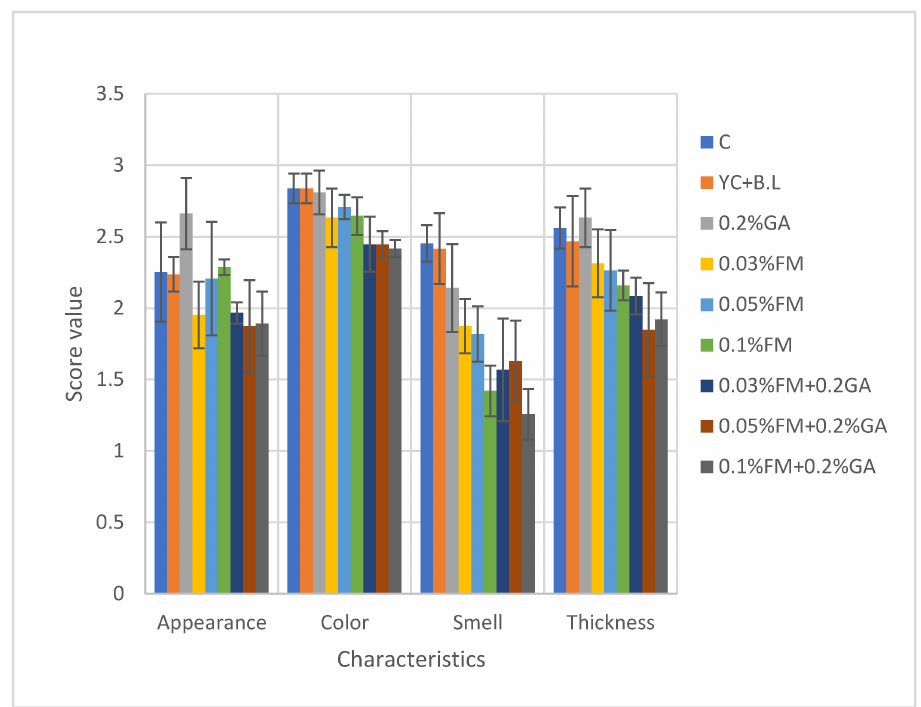
Figure 5. Effect of FM and GA on sensory evaluations during storage time. All scores are the mean of seven data points, n = 31. Abbreviations: C, control; YC, yogurt culture; B.L, B. lactis ; GA, gum arabic; FM, flaxseed